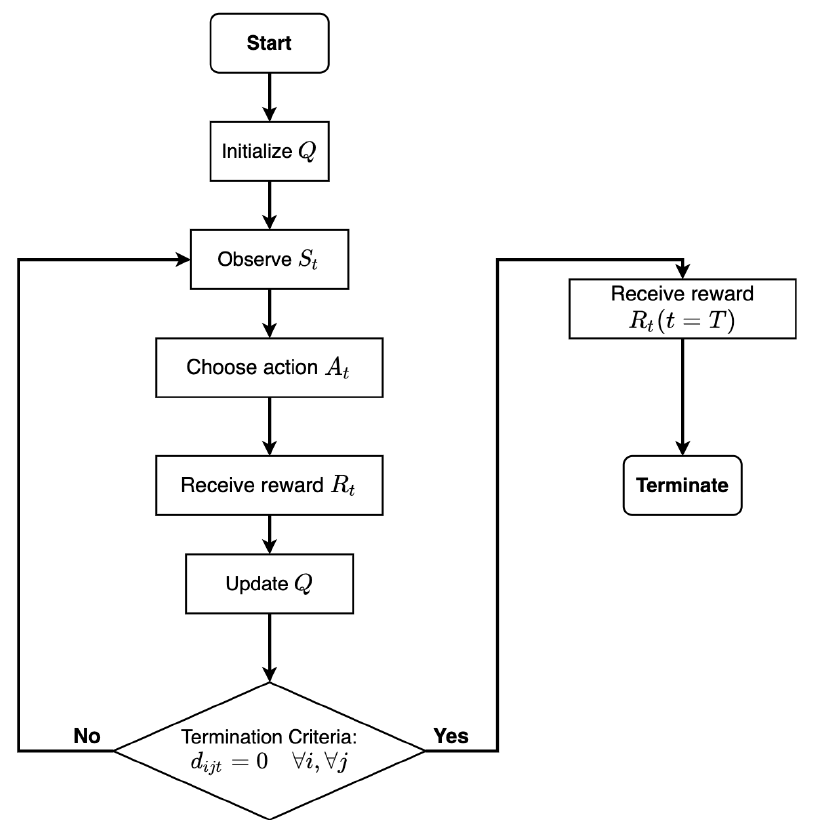
Figure 7. QL algorithm procedure at each episode.